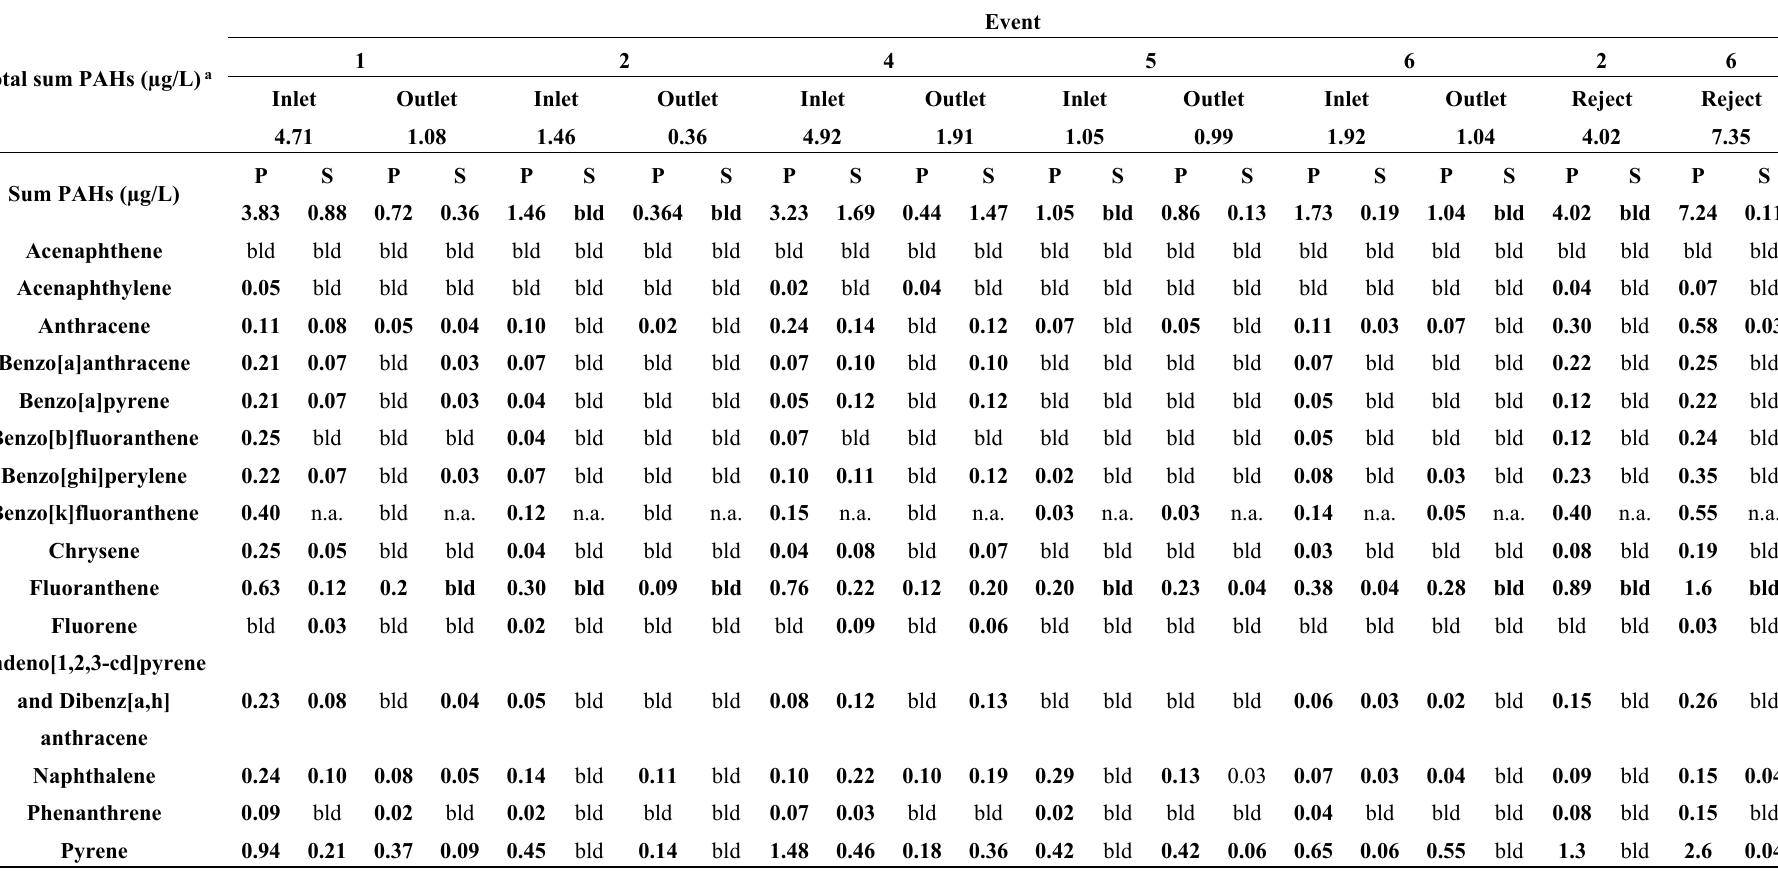
Table 2. PAHs measurements from collected stormwater samples in µg/L. Both the particulate fractions (particles > 0.7 µm) (P) and the suspended fraction (particles < 0.7 µm) (S) is shown. Event 3 was not possible to measure. Measurements on two collected reject water samples have also been